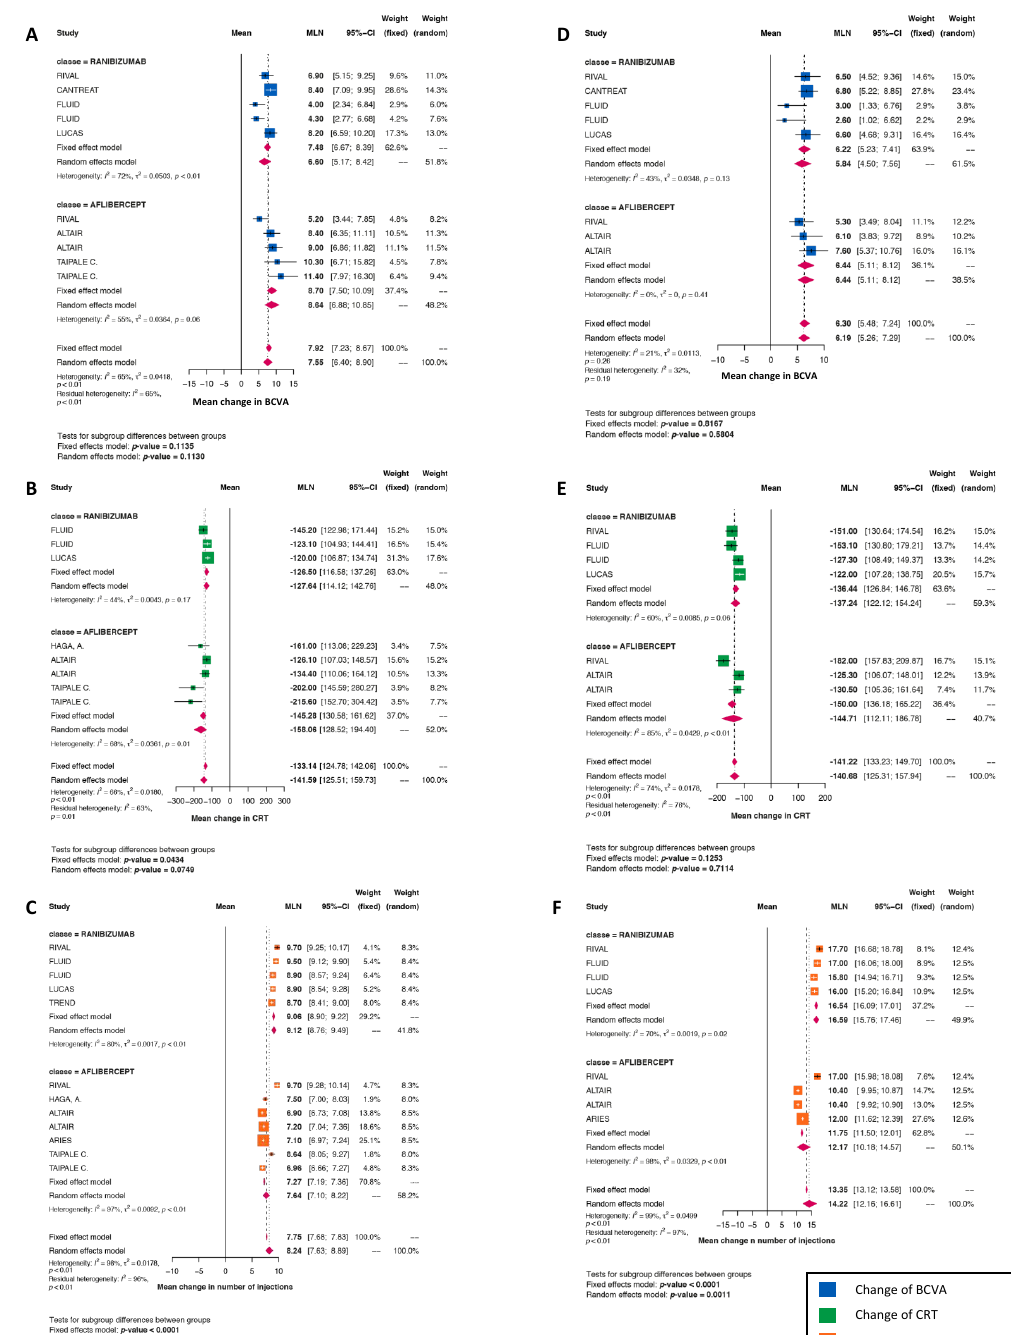
Figure 4. T&E regimen, Aflibercept versus Ranibizumab. ( A – C ): Mean change at 1 year, in best corrected visual acuity (( A ), blue squares), in CRT (( B ), green squares) and in the number of injections (( C ), orange squares). ( D – F ): Mean change at 2 years, in best corrected visual acuity (( D ), blue squares), in CRT (( E ), green squares) and in the number of injections (( F ), orange